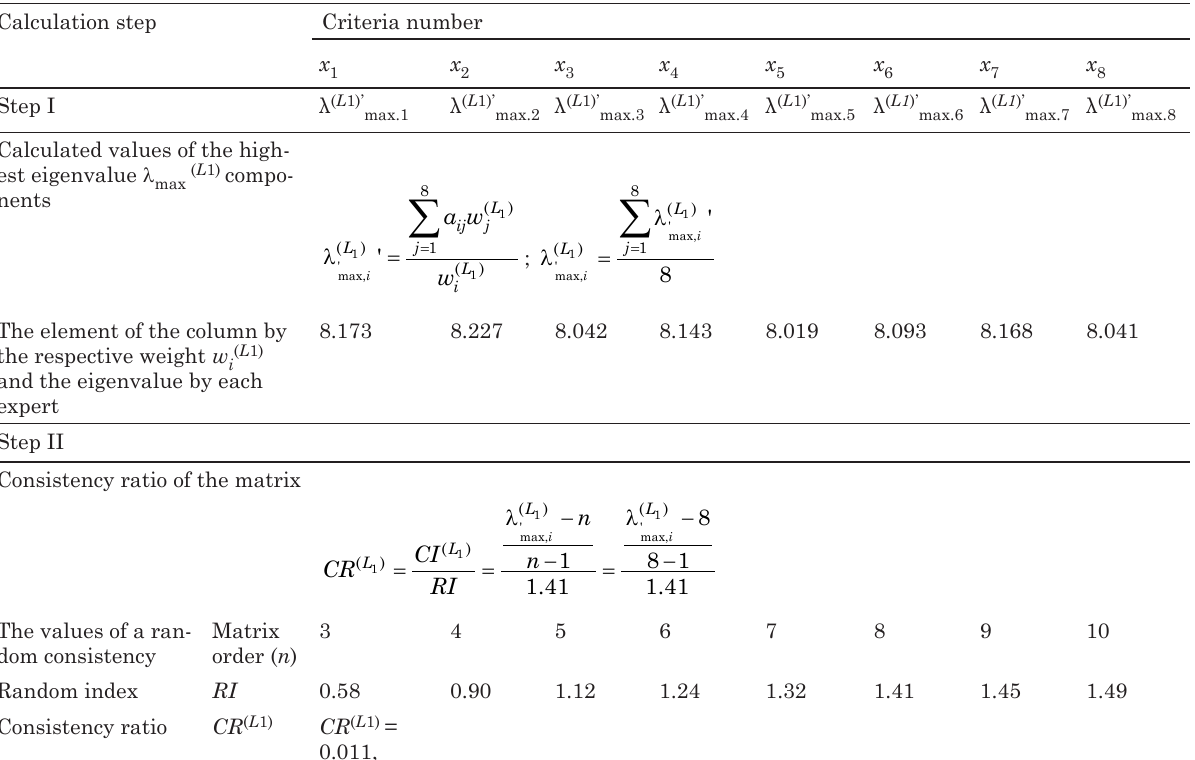
Table 5. Consistency of the matrix and agreement between expert